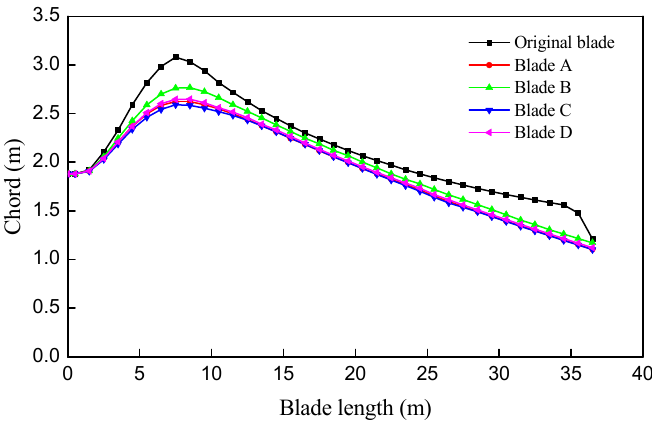
Figure 13. Comparison of chord distributions.